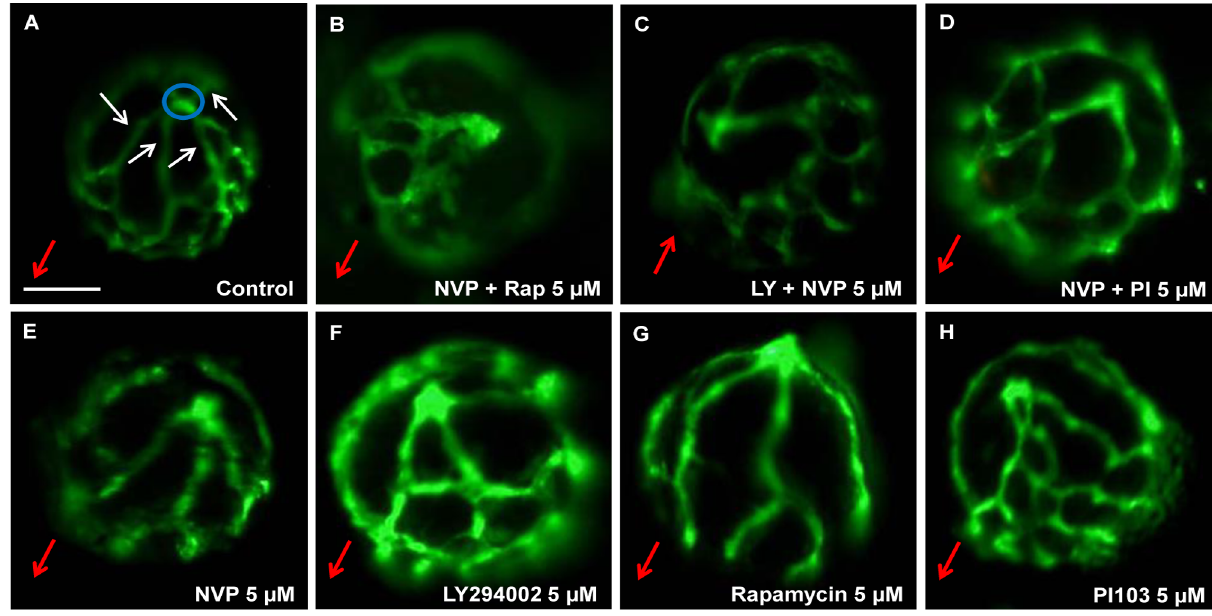
Figure 5. Qualitative effects of PI3K/Akt/mTOR inhibitors on ocular angiogenesis. Representative images demonstrating anti-angiogenic effects of PI3K/Akt/mTOR inhibitors on development of HV. 5 m M NVP-BEZ235 + Rapamycin (B), 5 m M LY294002 + NVP-BEZ235 (C) and 5 m M NVP- BEZ235 + PI103 (D) exhibited significant reductions in primary HV branch number compared to 0.1% DMSO-treated larvae (A). Small, but significant differences were observed in the number of primary branches and overall hyaloid vasculature patterning in 5 m M NVP-BEZ235, 5 m M LY294002, 5 m M Rapamycin and 5 m M -PI103-treated larvae (E-H) compared to control (A). Blue circles depict the optic nerve head. White arrows label primary HV branches emanating from the optic disc at the back of the lens. Red arrows indicate the lens orientation pointing in the direction from the optic disk to the lens. Scale bar 100 m m. N =26–30.